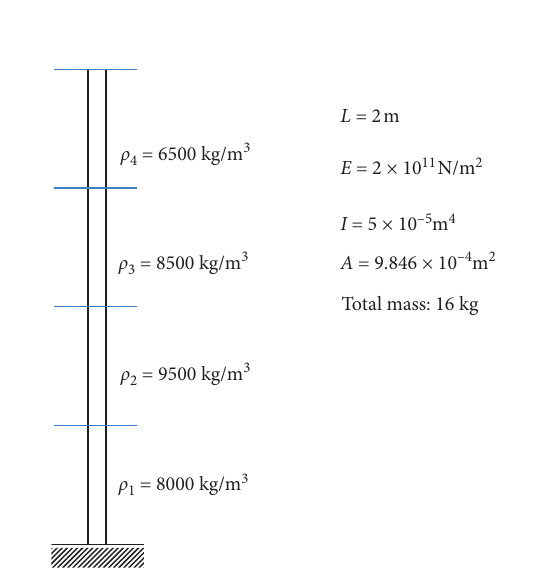
Figure 5: Cantilever beam with nonconstant mass density.